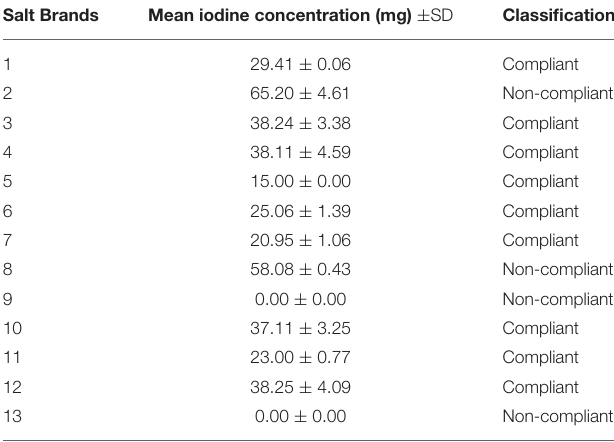
TABLE 3 | Analysis of iodine concentration in different brands of commercial salt available in local establishments.